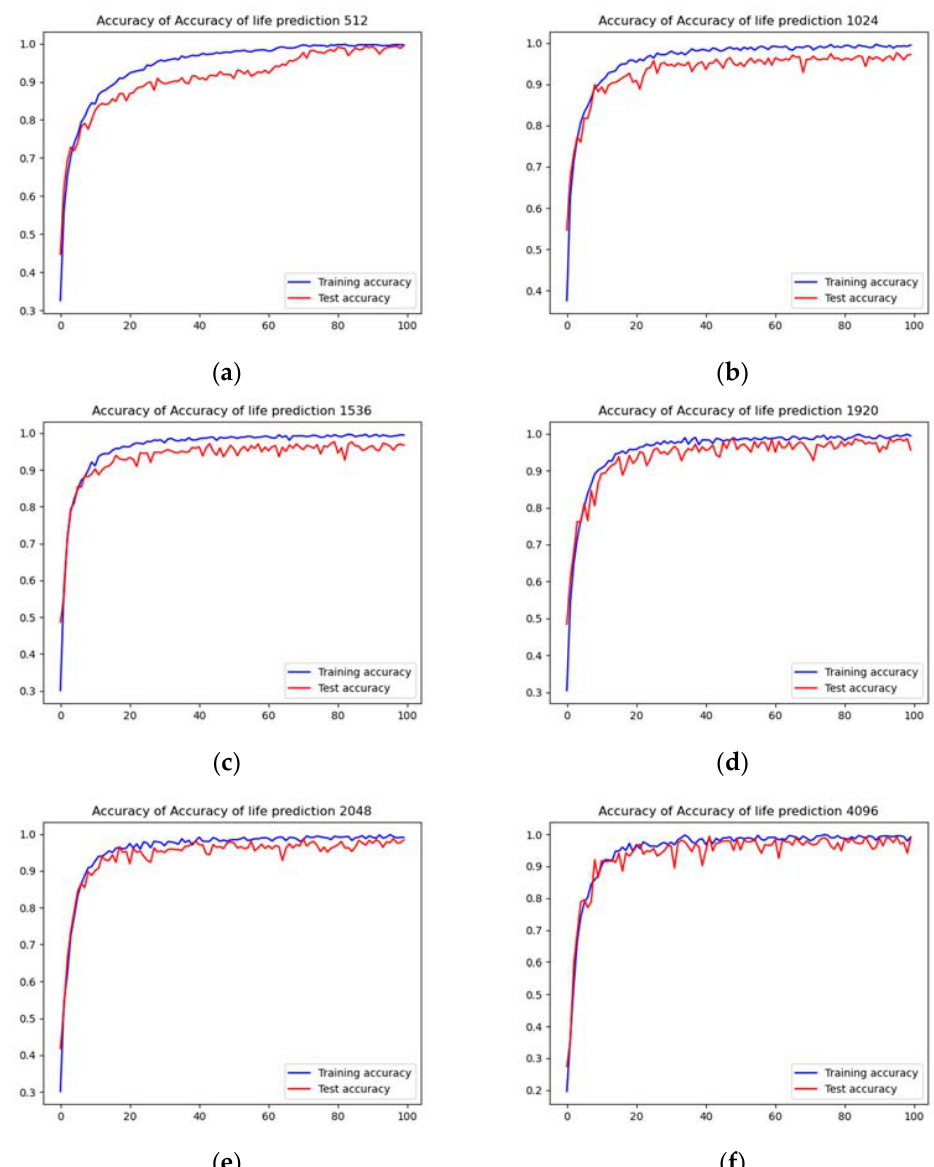
Figure 7. Accuracy curves of the proposed model with different sampling length: ( a ) Sampling length = 512; ( b ) Sampling length = 1024; ( c ) Sampling length = 1536; ( d ) Sampling length = 1920; ( e ) Sampling length = 2048; ( f ) Sampling length = 4096. Table 4. Comparison of experimental results for internal gear pumps.